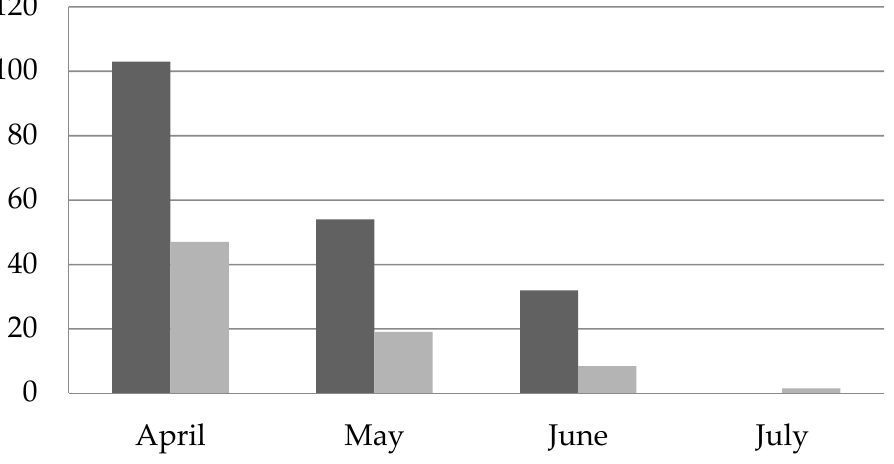
Figure 1. Rainfall (mm) during maize growth in Alger in 2018 (dark gray) and 2019 (light gray). The experimental design was a split–split plot with three repetitions. Each repetition was divided into two main plots that contain the two water regimes (well-watered and water-stressed). The nitrogen treatment (0 kg of nitrogen and 120 kg of nitrogen) was arranged in the subplots, and the genotypes in the sub-subplots. Each experimental unit was a single-row plot, 6 m long with 0.7 m row spacing, and the hills were spaced 0.2 m, to reach a final plant density of approximately 70,000